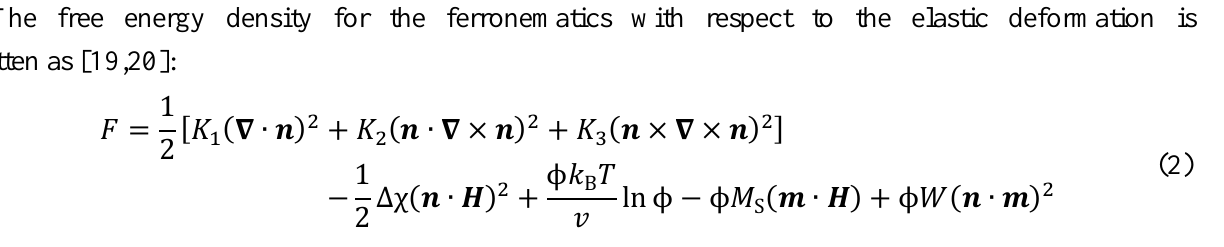
Figure 5. Relative intensity ( I / I 0 ) as a function of the applied magnetic field ( B ), for 1 and 2a – c